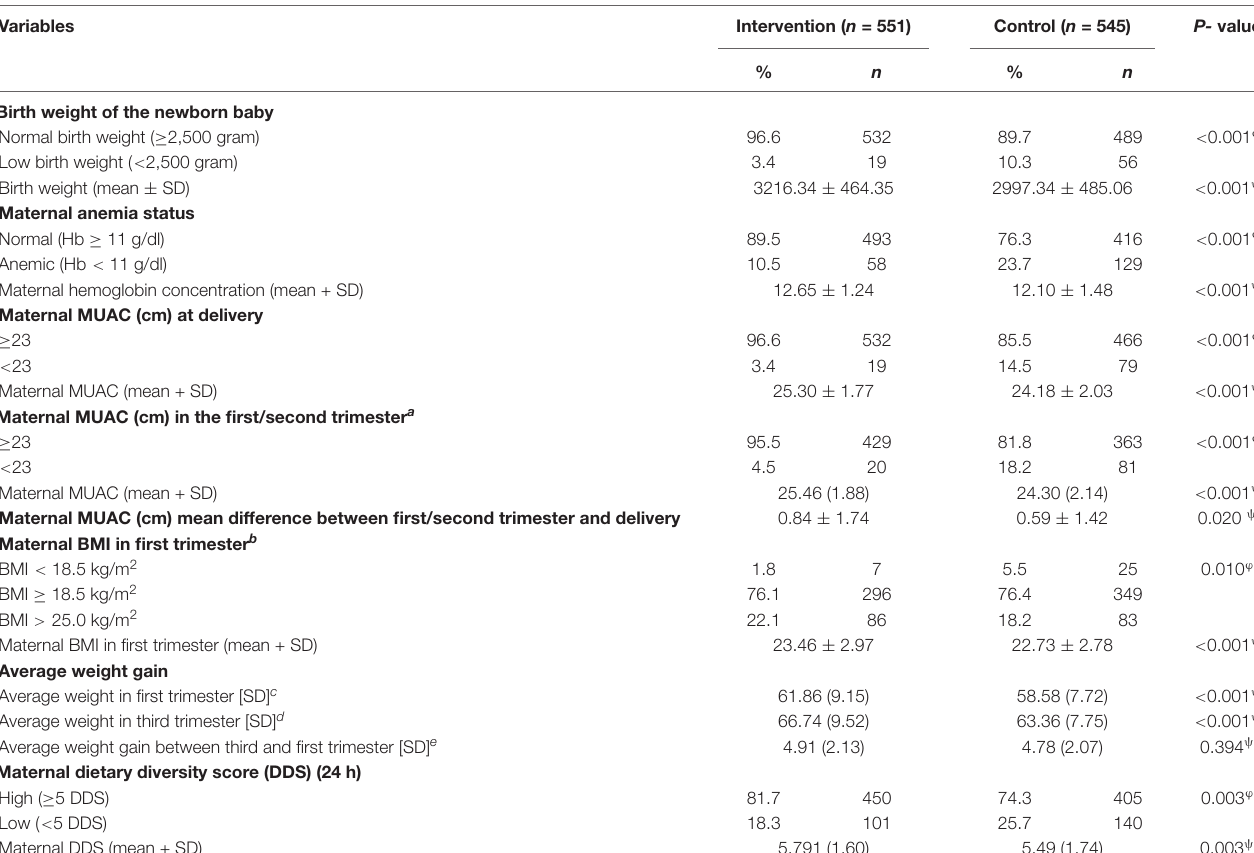
TABLE 2 | Maternal nutritional and birth weight status by study group. Variables Intervention ( n = 551) Control ( n = 545) P-